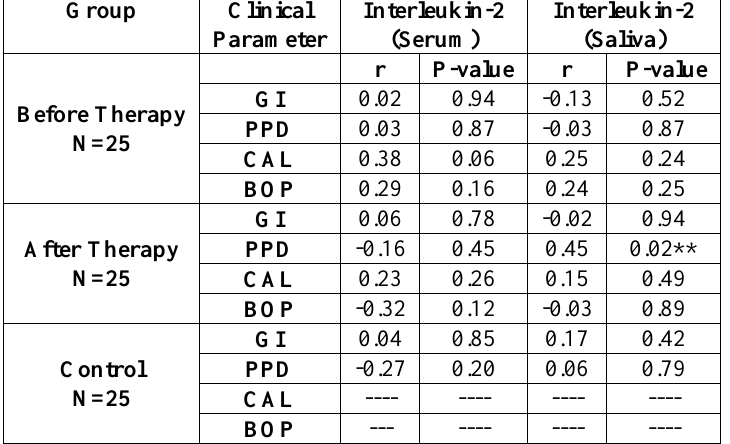
---- ---- ---- BOP --- ---- ---- ---- r=Spearman rank correlation